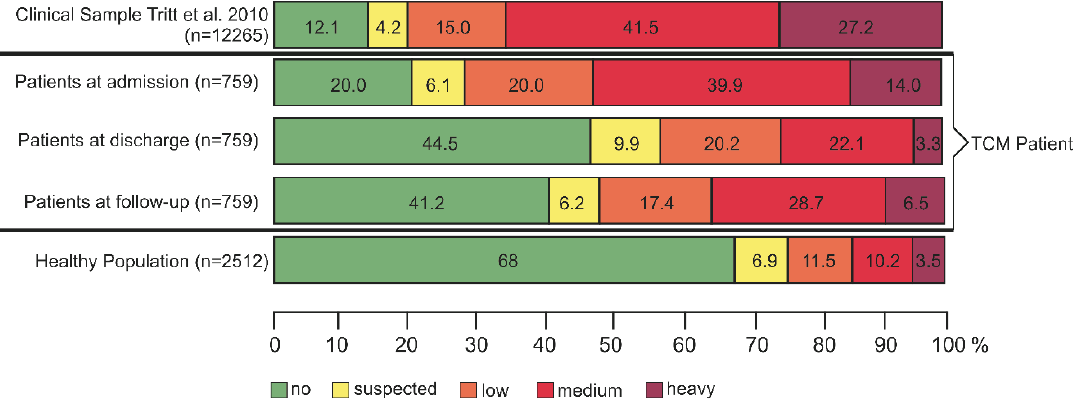
Figure 5. Comparison of ISR symptom loads between in-patients of the TCM Hospital Bad Kötzting, Germany, and peer samples.